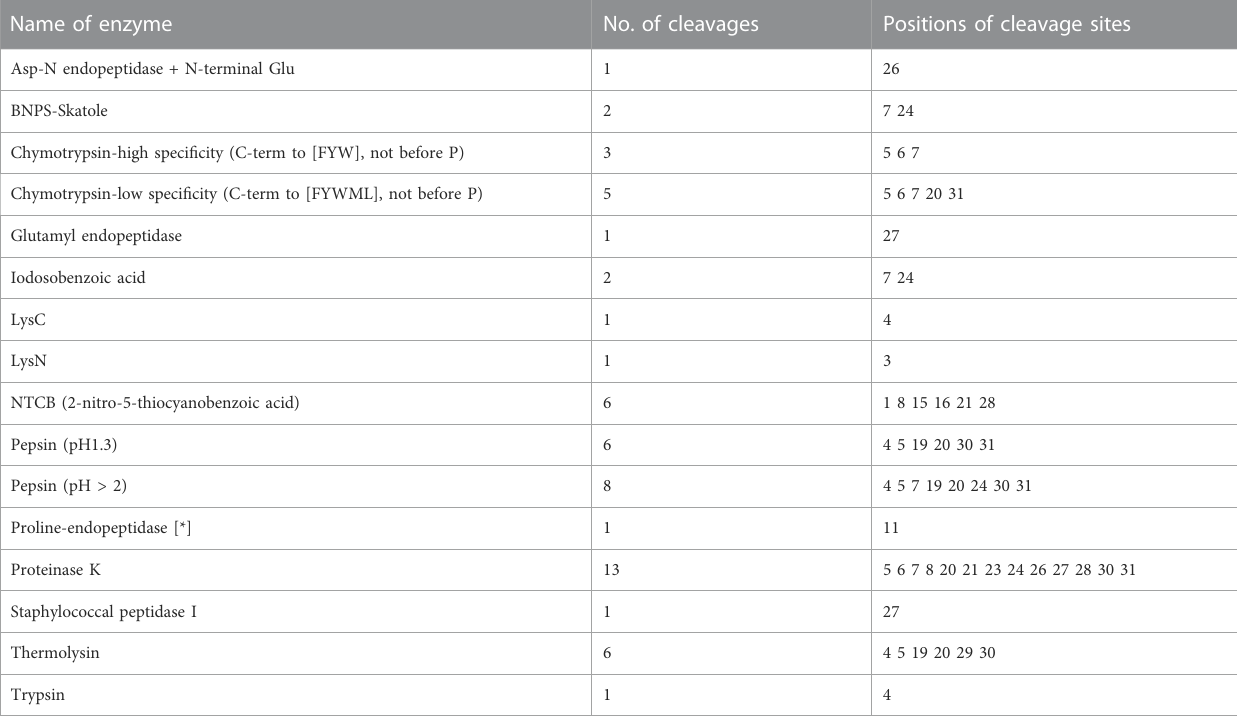
TABLE 2 The predicted shear sites of JZTX-14. Name of enzyme No. of cleavages Positions of cleavage